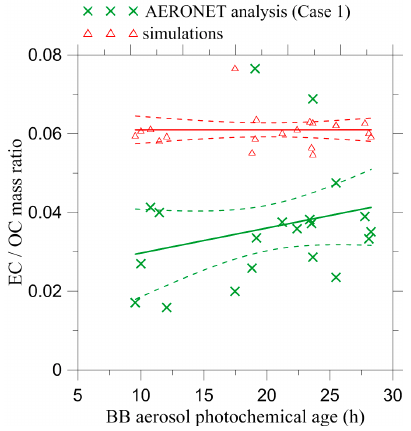
Figure 7. The dependence of the EC/OC mass ratio on the photochemical age of BB aerosol according to the analysis based on the AERONET data (see the green solid line) and the simulations with the CHIMERE CTM (see the red solid line). The corresponding 90% confidence intervals of the linear fits (simple linear regressions) are shown by the green and red dashed lines.